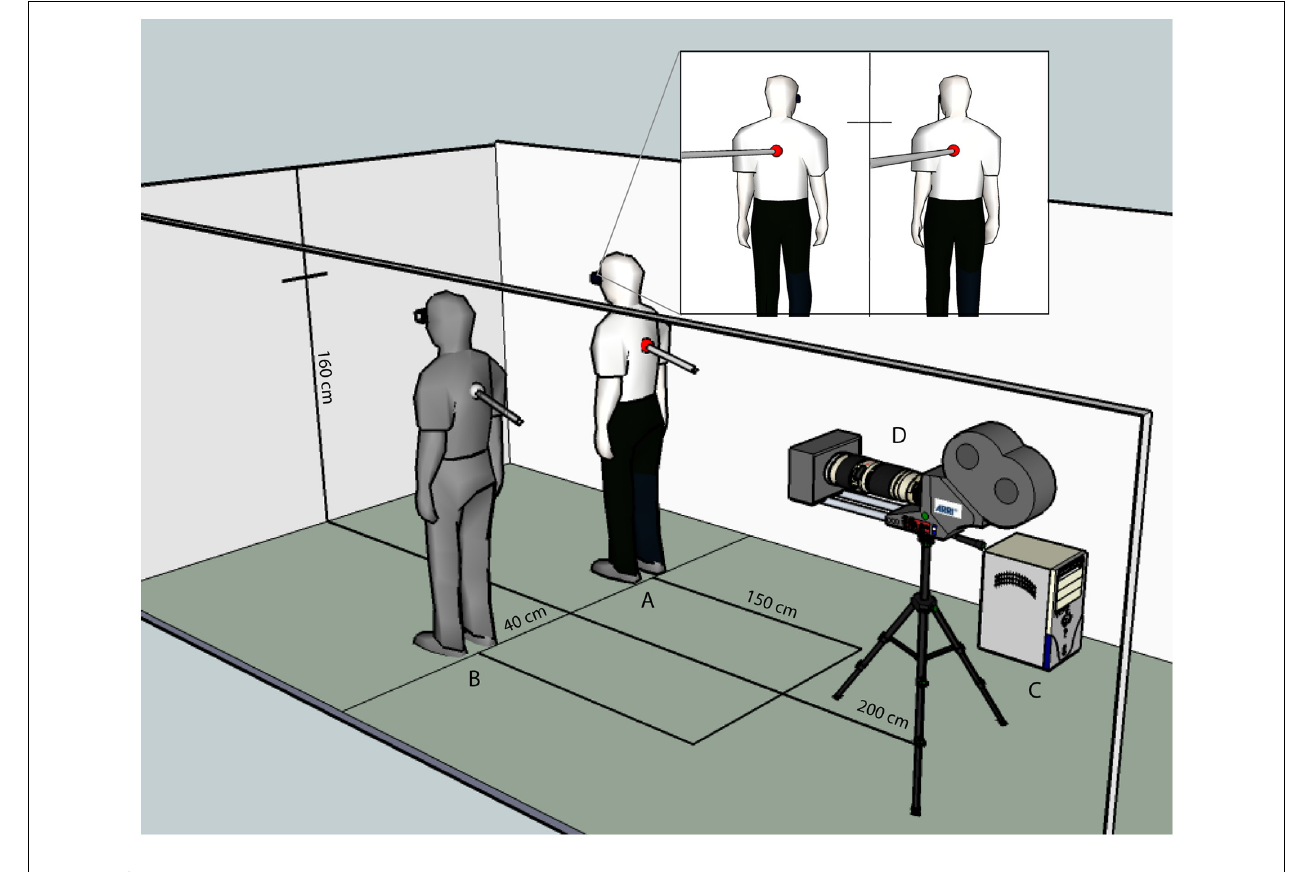
FIGURE 1 | Setup Study 1. Participants stood at a distance of 2 m and with their backs facing a video camera. Participants were either standing to the right or the left of the midline. (A) Refers to the location of the participant,